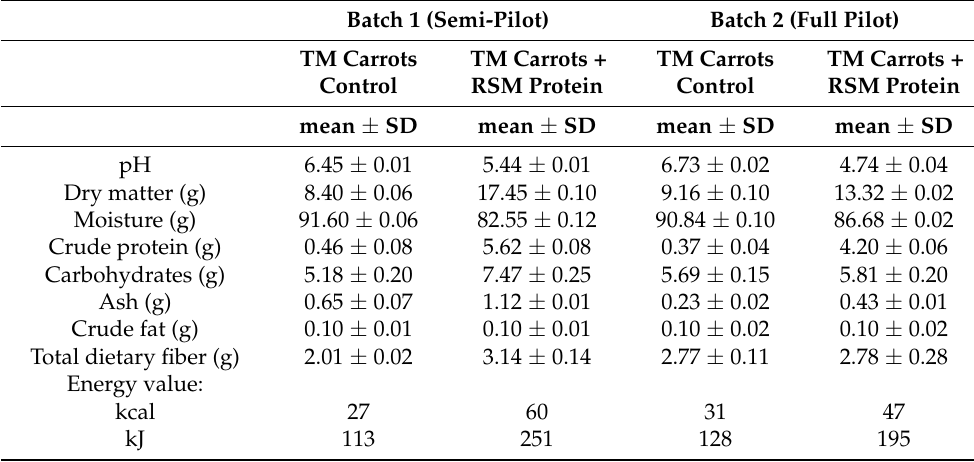
Table 6. Macronutrient composition and energy value of TM carrots: control and RSM-protein- supplemented (5% w/w ) samples. Values are expressed per 100 g of fresh